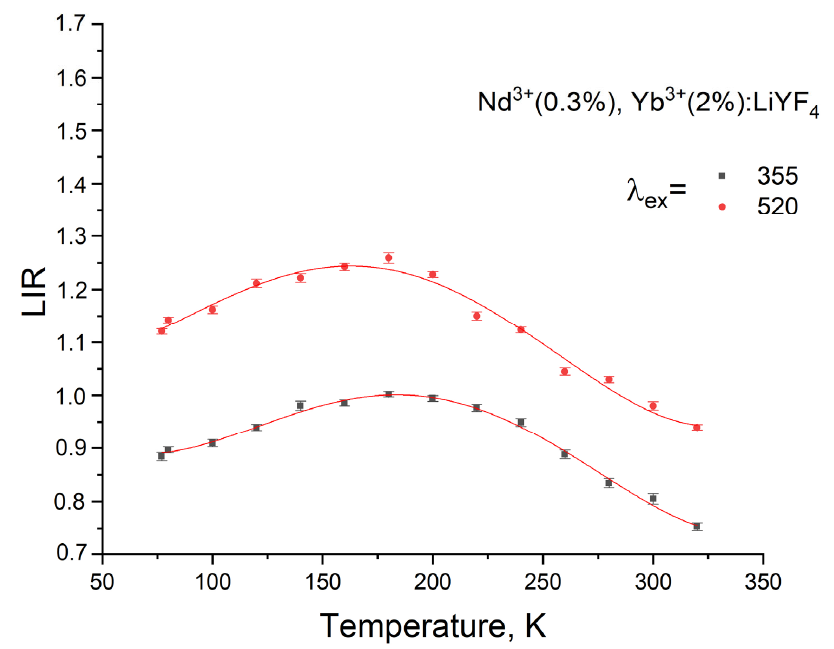
Photonics 2023 , 10 , x FOR PEER REVIEW Figure 8. The LIR curves of both I(Nd 3+ , 4 F 3/2 – 4 I 9/2 , ~866 nm) and I (Yb 3+ , 2 F 5/2 – 2 F 7/2 , ~980 nm) luminescence peaks at different excitation wavelengths λ ex = 520 nm and λ ex = 355 nm.